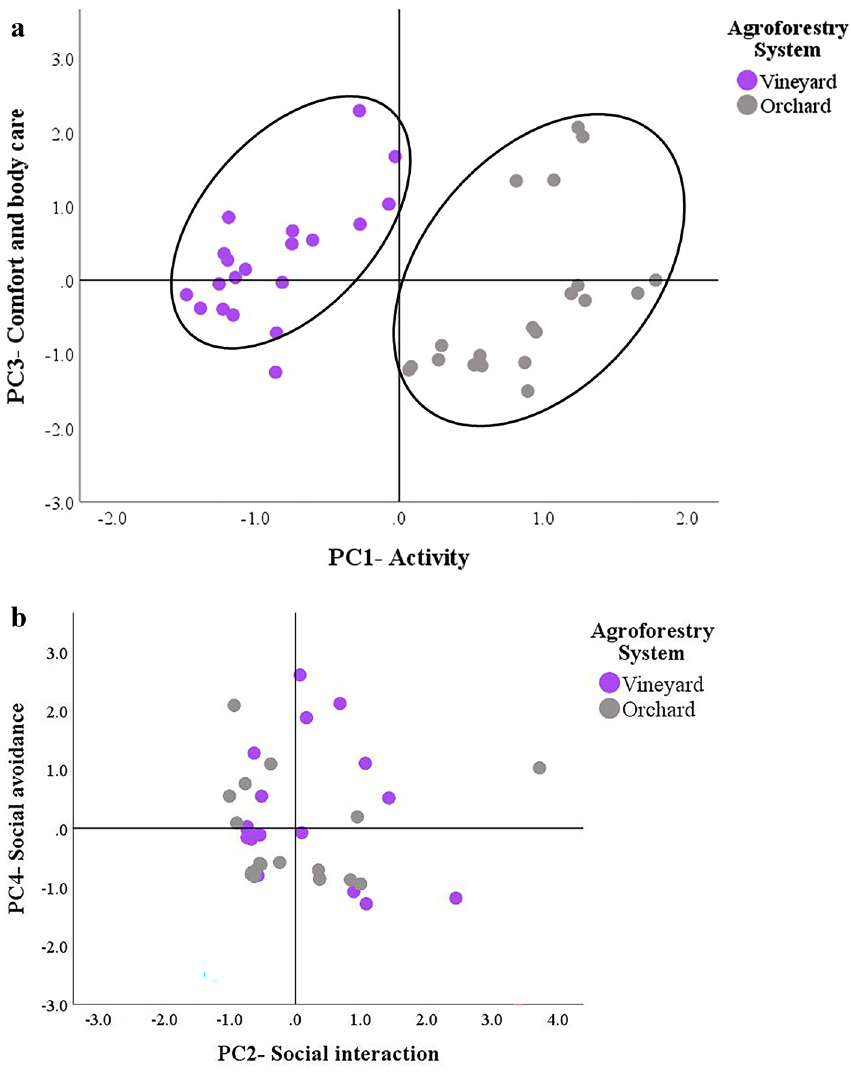
Figure 2. Principal component analysis score plots. Score plots of the dimensions related to ( a ) locomotor- relaxation activity (e.g., PC1 and PC3) and ( b ) sociability (e.g., PC2 and PC4) according to the agroforestry